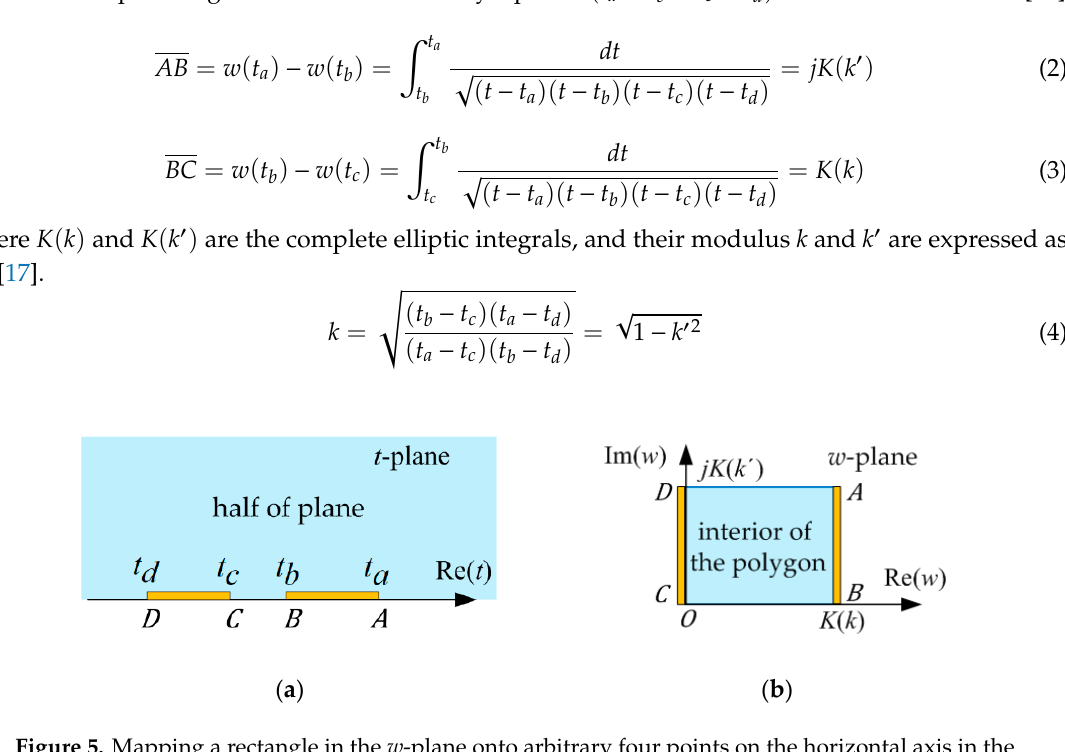
Figure 5. Mapping a rectangle in the w -plane onto arbitrary four points on the horizontal axis in the t -plane: ( a ) t -plane, ( b ) w -plane. Region